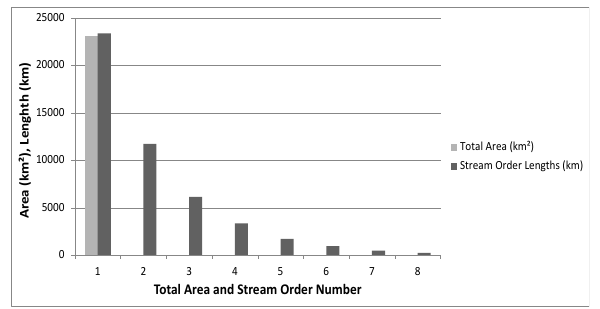
Figure 8, SEQ Land Area - Stream Orders